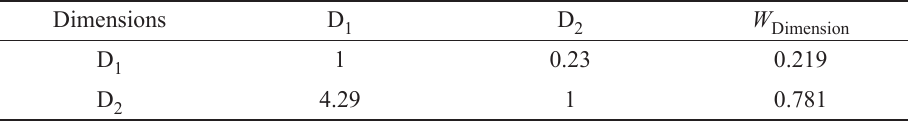
Table 2. Pair-wise comparison matrix and weights of assessment dimensions Dimensions